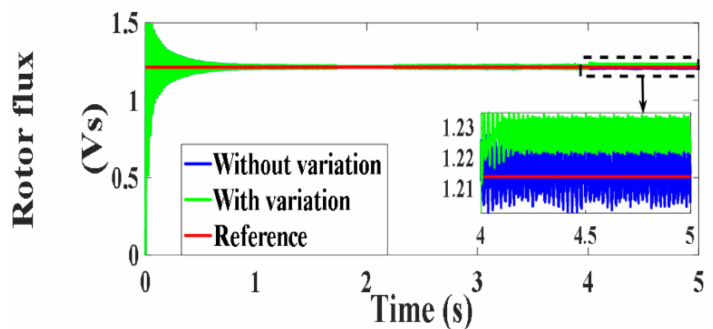
Figure 166. Rotor flux under PVC (Vs).